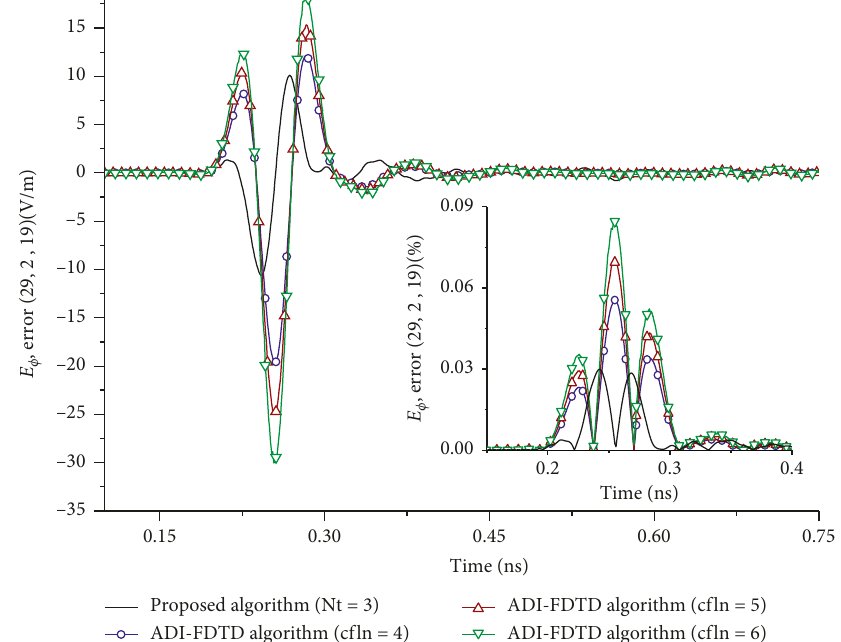
Figure 9: Errors obtained by E